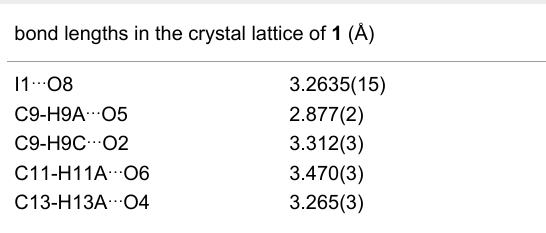
Table 2: Halogen and hydrogen bonds in 1